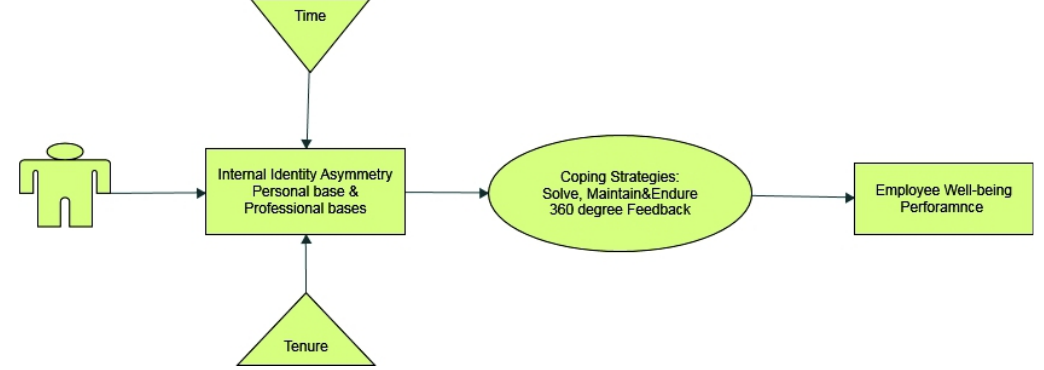
Figure 2 : Conceptual